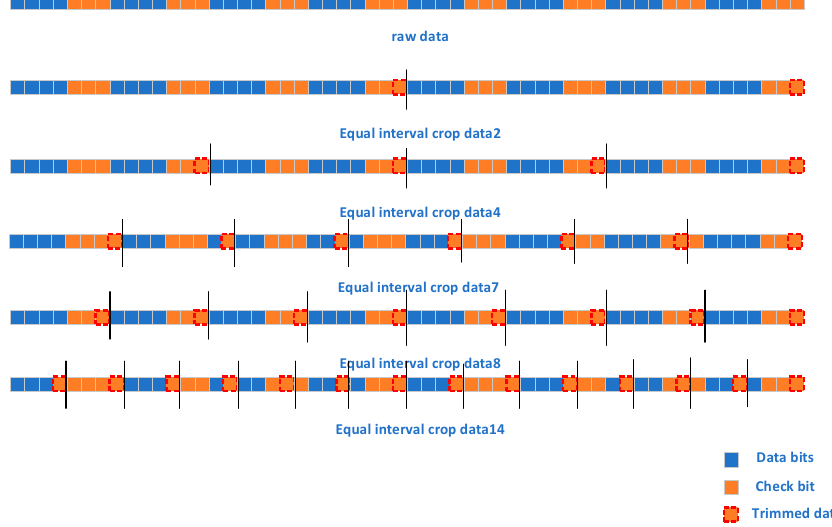
Figure 13. Comparison of equally spaced cropped data.